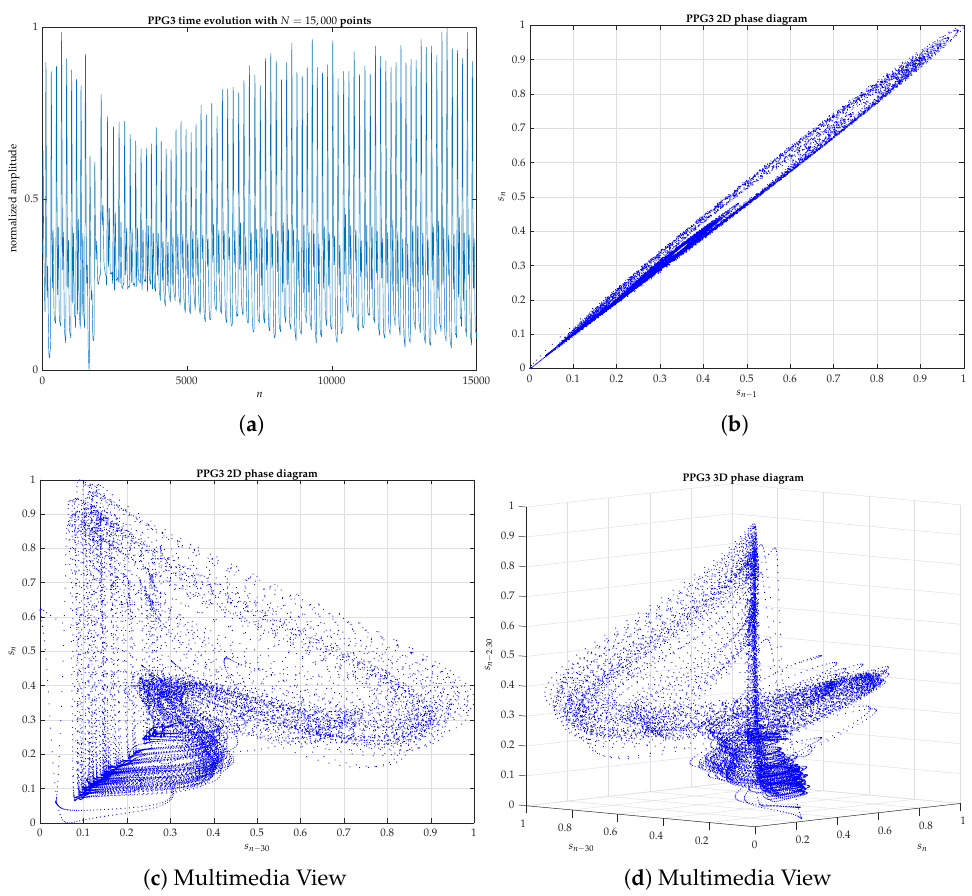
Figure A6. PPG signal of the healthy young Subject Number 3 (PPG3): ( a ) One minute PPG recorded signal. ( b ) PPG3 2D phase diagram with τ = 1. ( c ) PPG3 2D phase diagram with τ = 30, according to Table 1. PPG3 video clip of the evolution of phase diagram from τ = 1 to τ = 150 in 2D. ( d ) PPG3 3D phase diagram with τ = 30. PPG3 video clip of the evolution of phase diagram from τ = 1 to τ = 150 in